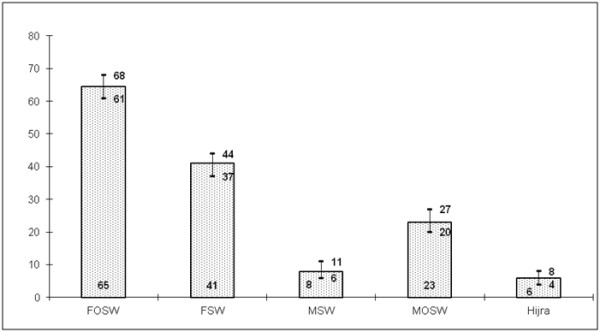
Type of sexual partners among men who reported non-marital sex with 95% CI (n = 697).